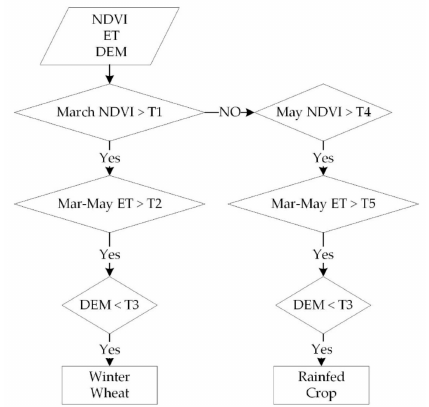
Figure 3. Winter wheat and rainfed crops planting area extraction model. Where March NDVI and Mar-May ET represent the NDVI in March (May NDVI is similar to March NDVI) and cumulative amount of ET from March to May, respectively; DEM is the elevation information; and T is the threshold in di ff erent conditions. If the pixel value (such as NDVI and ET) satisfies the threshold, the pixel value is 1, and if it is not satisfied, the pixel value is